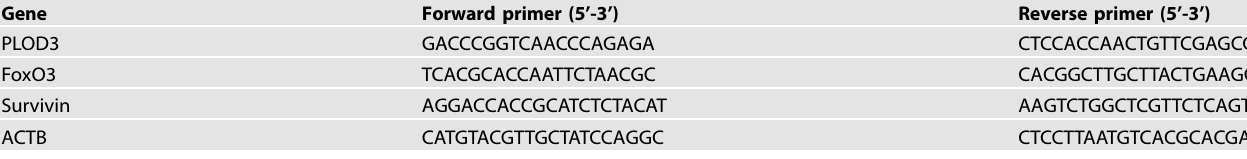
Table 1. Primers used in RNA